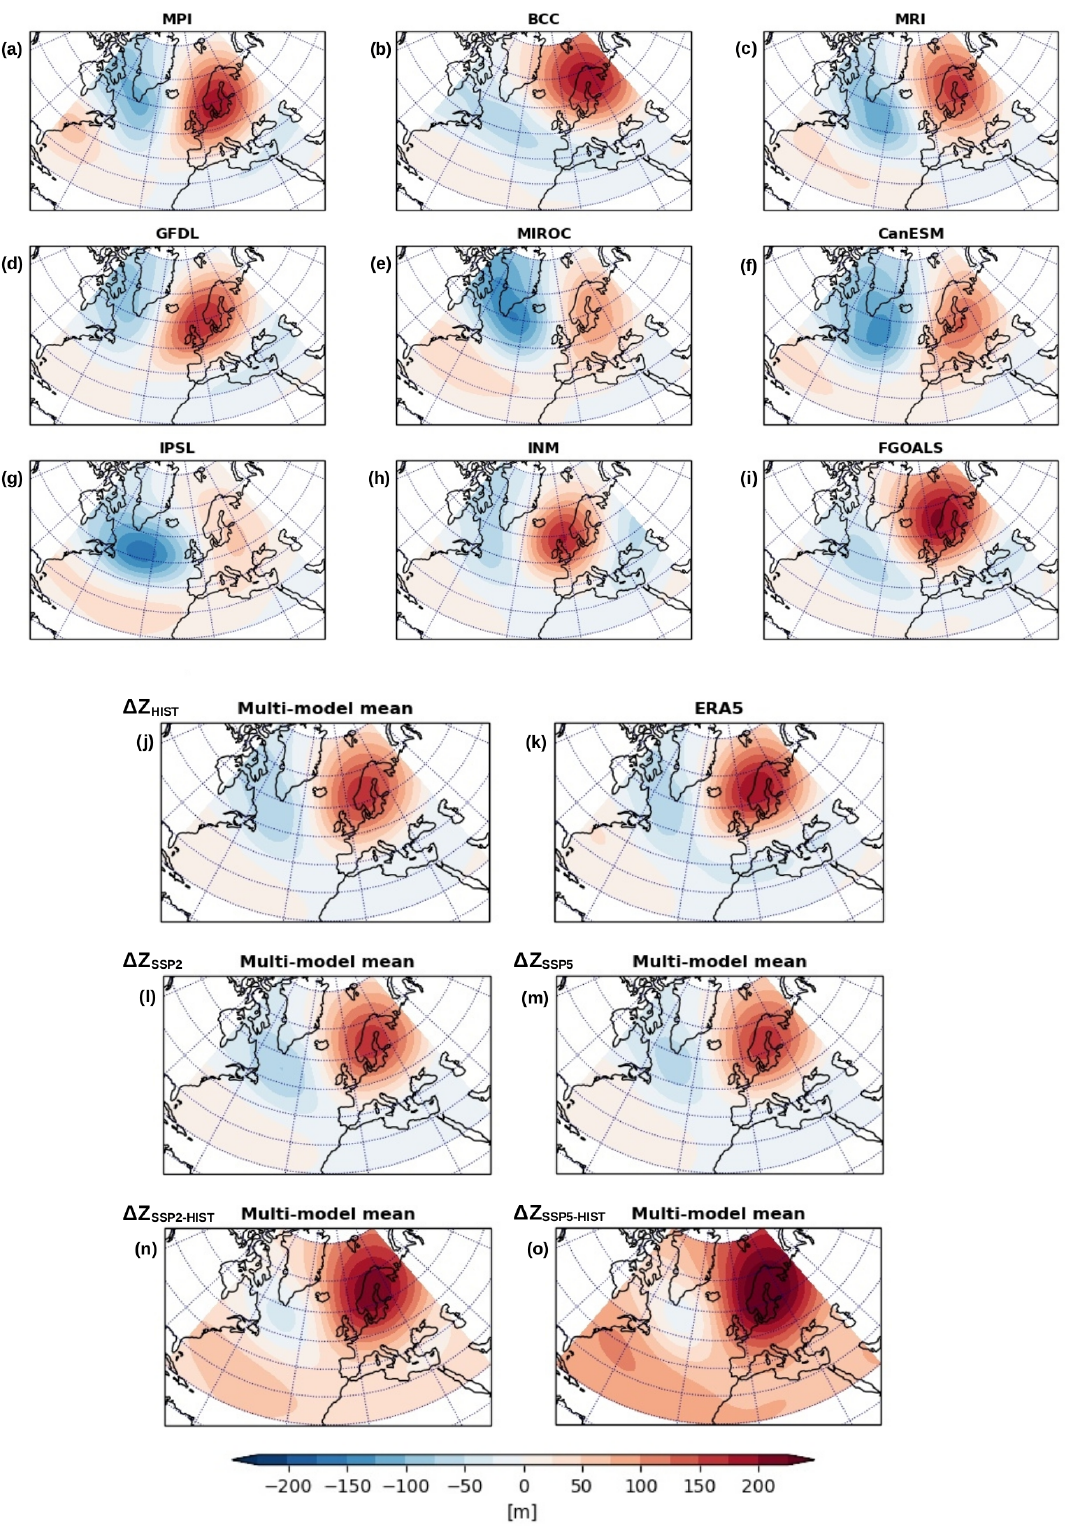
Figure 2. Blocking composites averaged over all blocking events for each GCM (a–i) and ERA5 (k) during the winter HIST period (1980–2009). The multi-model means are computed over all blocking events of the six selected GCMs for the HIST period (1980– 2009) using (cid:49) Z500 HIST (j) and for the future period (2070–2099) using (cid:49) Z500 SSP2 (l) , (cid:49) Z500 SSP5 (m) , (cid:49) Z500 SSP2 − HIST (n) , and (cid:49) Z500 SSP5 − HIST (o)